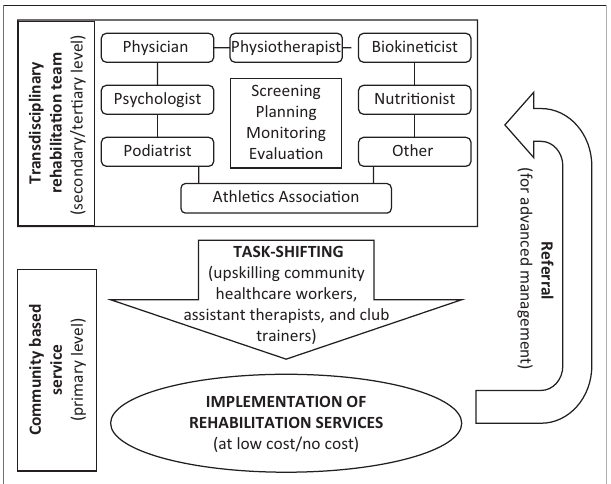
FIGURE 2: Proposed framework for injury rehabilitation amongst runners in under-resourced